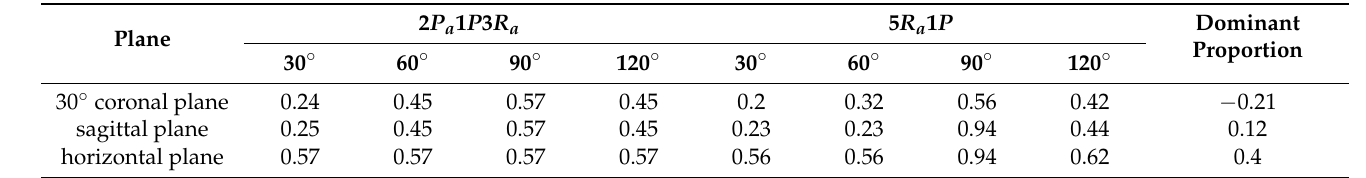
Table 3. Comparison of operability ellipsoids of the 2 P a 1 P 3 R a and 5 R a 1 P .